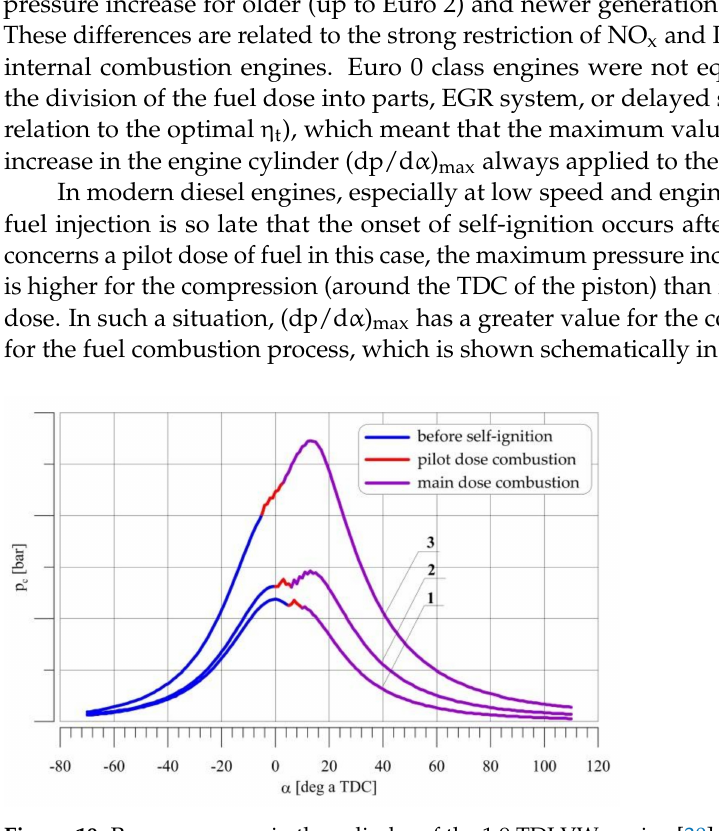
Figure 19. Pressure course in the cylinder of the 1.9 TDI VW engine